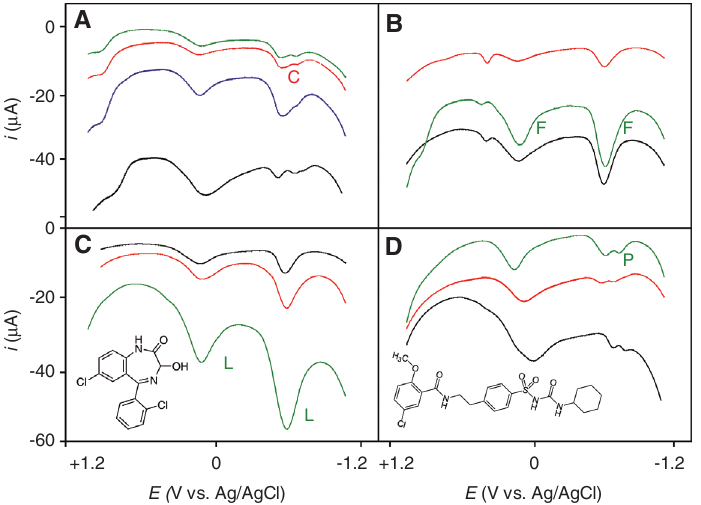
Figure 3 Square wave voltammograms initiated at +1.05 V in the negative direction for paraffin-impregnated graphite electrodes modified with different samples of herbal formulations (black lines) and standards of adulterants. A) chlorpropamide (C peaks, red), glibenclamide (green) and glimepiride (blue); B) a second sample (red) and furosemide (F peaks, green); C) a second sample (red) and lorazepam (L peaks, green); D) a second sample (red) and femproporex (P peaks, green). Electrolyte 0.25 m HAc/NaAc. Insets: structures of C) lorazepam and D) glibenclamide. Adapted from Doménech-Carbó et al. 2013b, with permission from